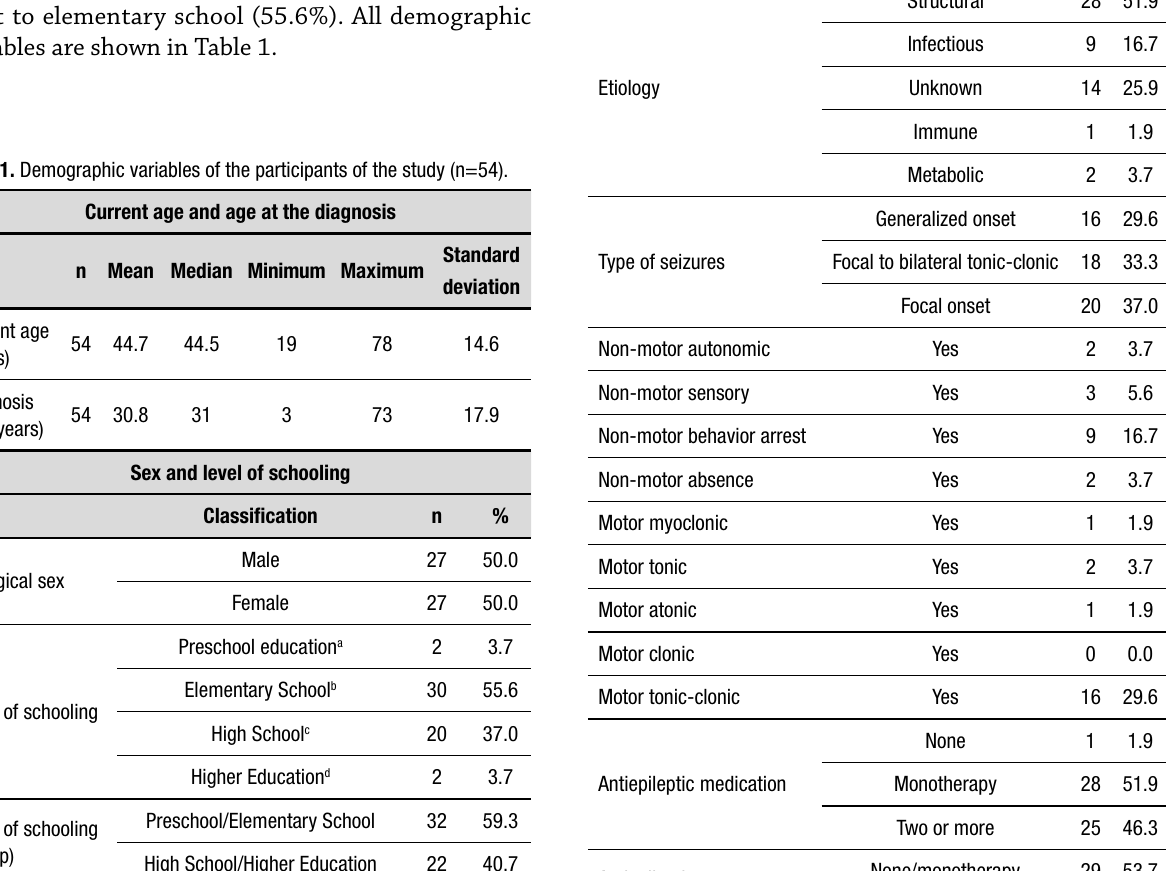
Table 2. Clinical variables of the participants of the study (n=54).